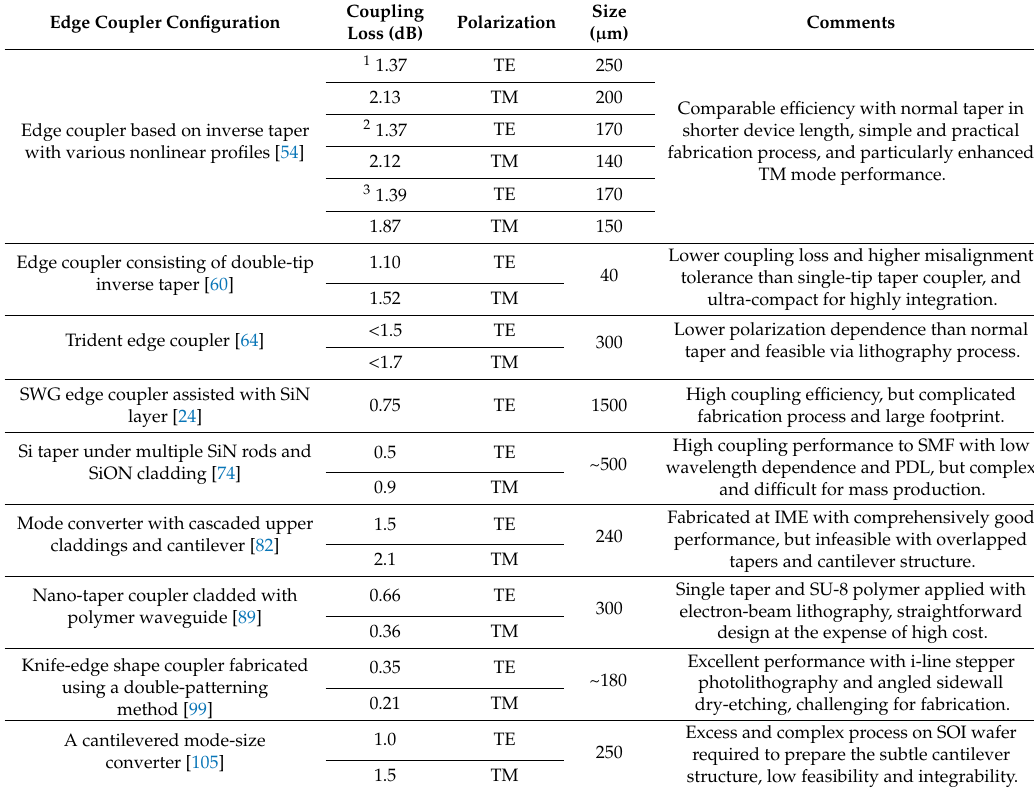
Table 1. Overviewofedgecouplerswithdifferentstructures. SMF:singlemodefiber, SWG:subwavelength gratings structure, PDL: polarization-dependent